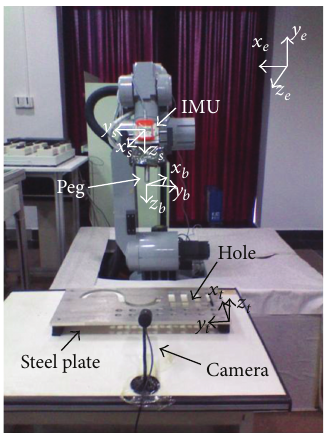
Figure 1: Structure of the system.